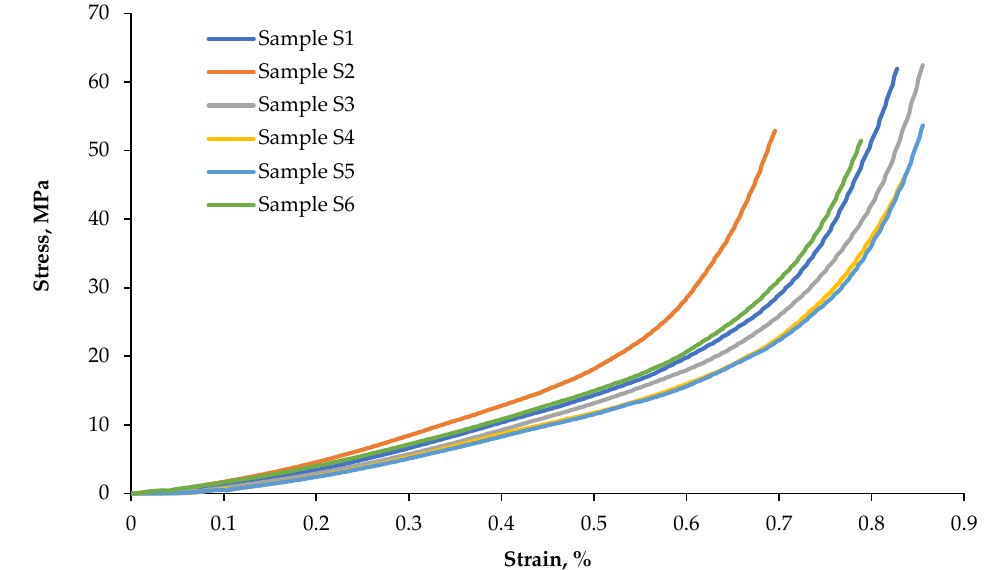
Figure 7. Waveforms of compressive stresses as a function of the deformation of specimens S1–S6. The standard deviation obtained from the test is S x = 0.5196, the critical value of the T-Student distribution, with k = n–1 degrees of freedom, is t α = 2.5706, and the significance level is α ist = 0.05.